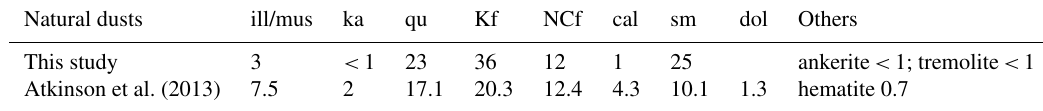
Table B1. Comparison of mineralogy of ATD determined by XRD from Atkinson et al. (2013) and this study. The abbreviations stand for ill/mus: illite/muscovite; ka: kaolinite; qu: quartz; Kf: K-feldspars, NCf: (Na, Ca)-feldspars; cal: calcite; sm: smectite; dol: dolomite. Natural dusts ill/mus ka qu Kf NCf cal sm dol Others This study 3 < 1 23 36 12 1 25 ankerite < 1; tremolite < 1 Atkinson et al. (2013) 7.5 2 17.1 20.3 12.4 4.3 10.1 1.3 hematite